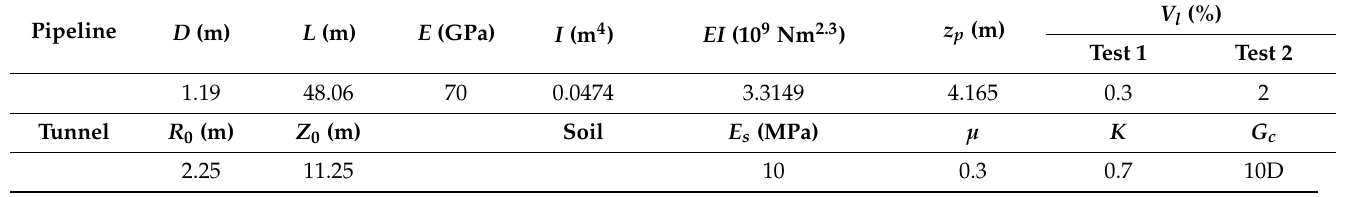
Table 1. Geometrical and physical parameters of centrifuge tests and analytical methods (Vorster, [43]; Liu et al. [29]).